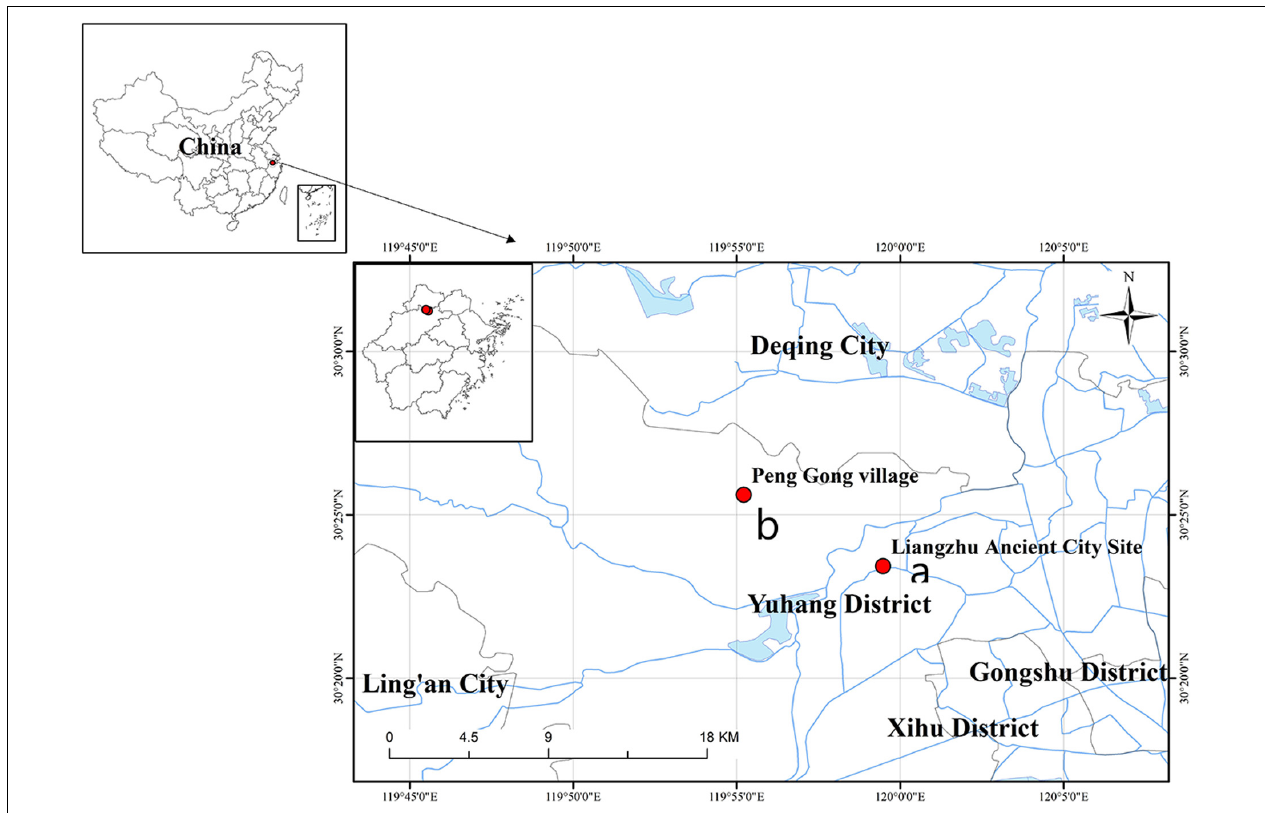
FIGURE 1 | Location of the Archaeological Ruins of Liangzhu City in Zhejiang Heze, China. (a) Location of the South Wall sampling point. (b) Location of the Tiger Ridge sampling point. The map was drawn using ArcGIS v.10.2